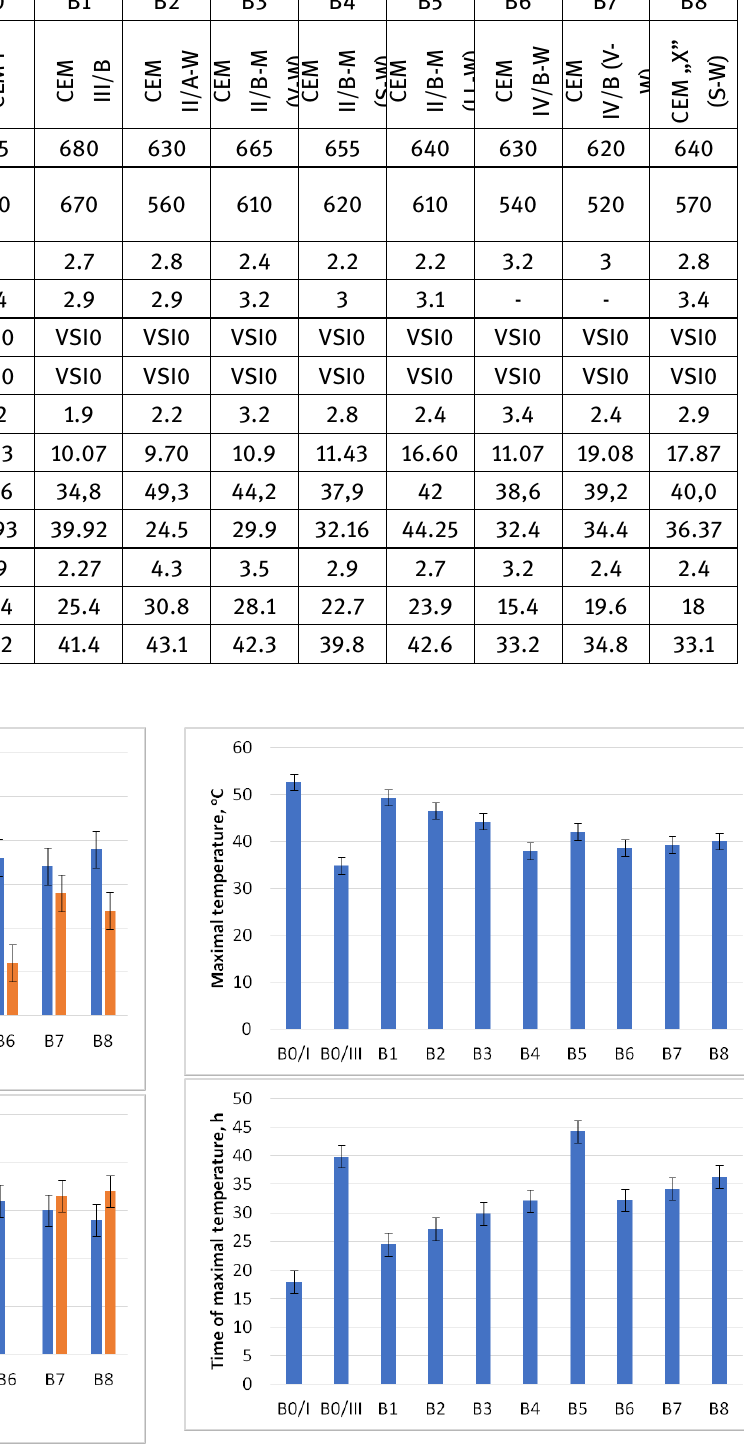
Figure 3: The influence of cement type on maximal temperature and time of obtaining maximal temperature of